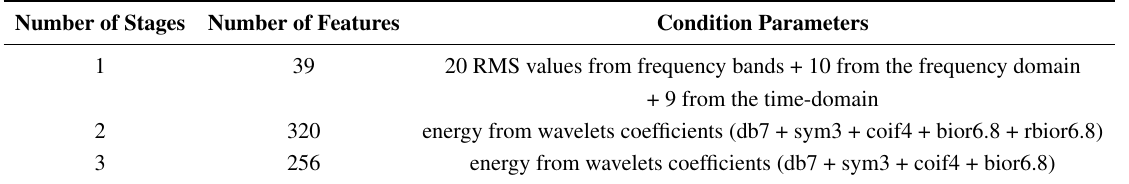
Table 3. Sets of the initial population. db7, Daubechies; sym3, symlet; coif4,